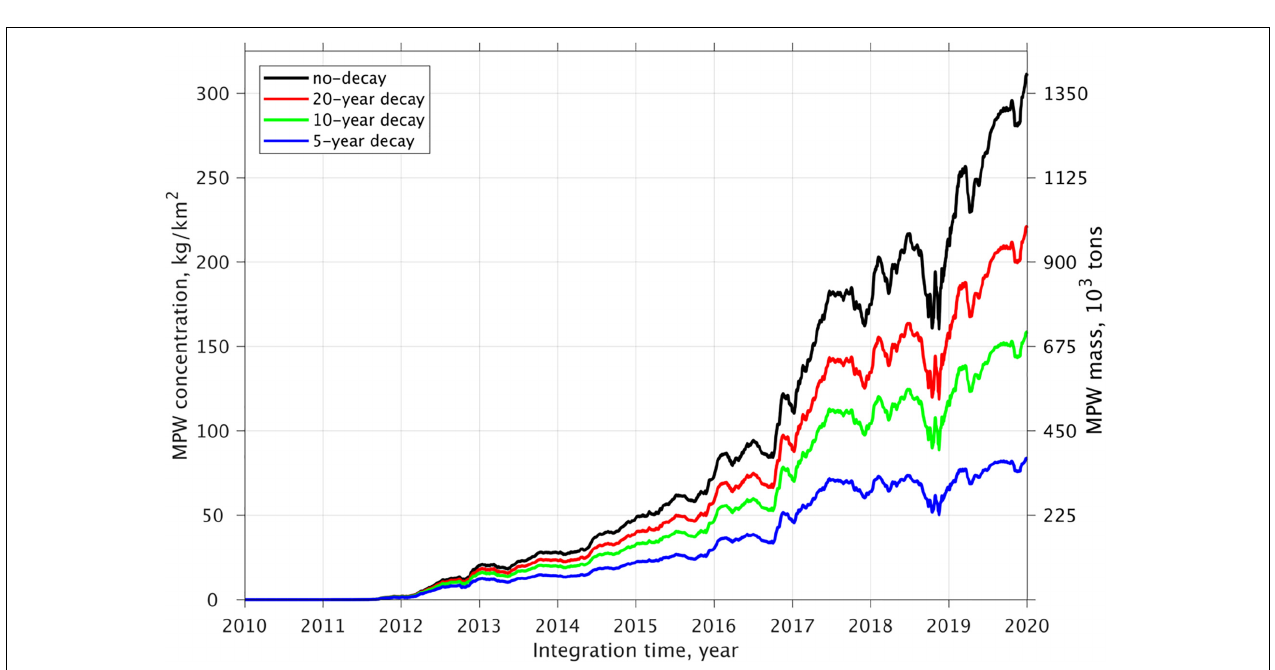
FIGURE 4 | The accumulation of the modeled mismanaged plastic waste concentration or mass in the GPGP area (129-156 ◦ W, 25-41 ◦ N, red rectangle box in Figure 3 ) under different decaying scenarios.